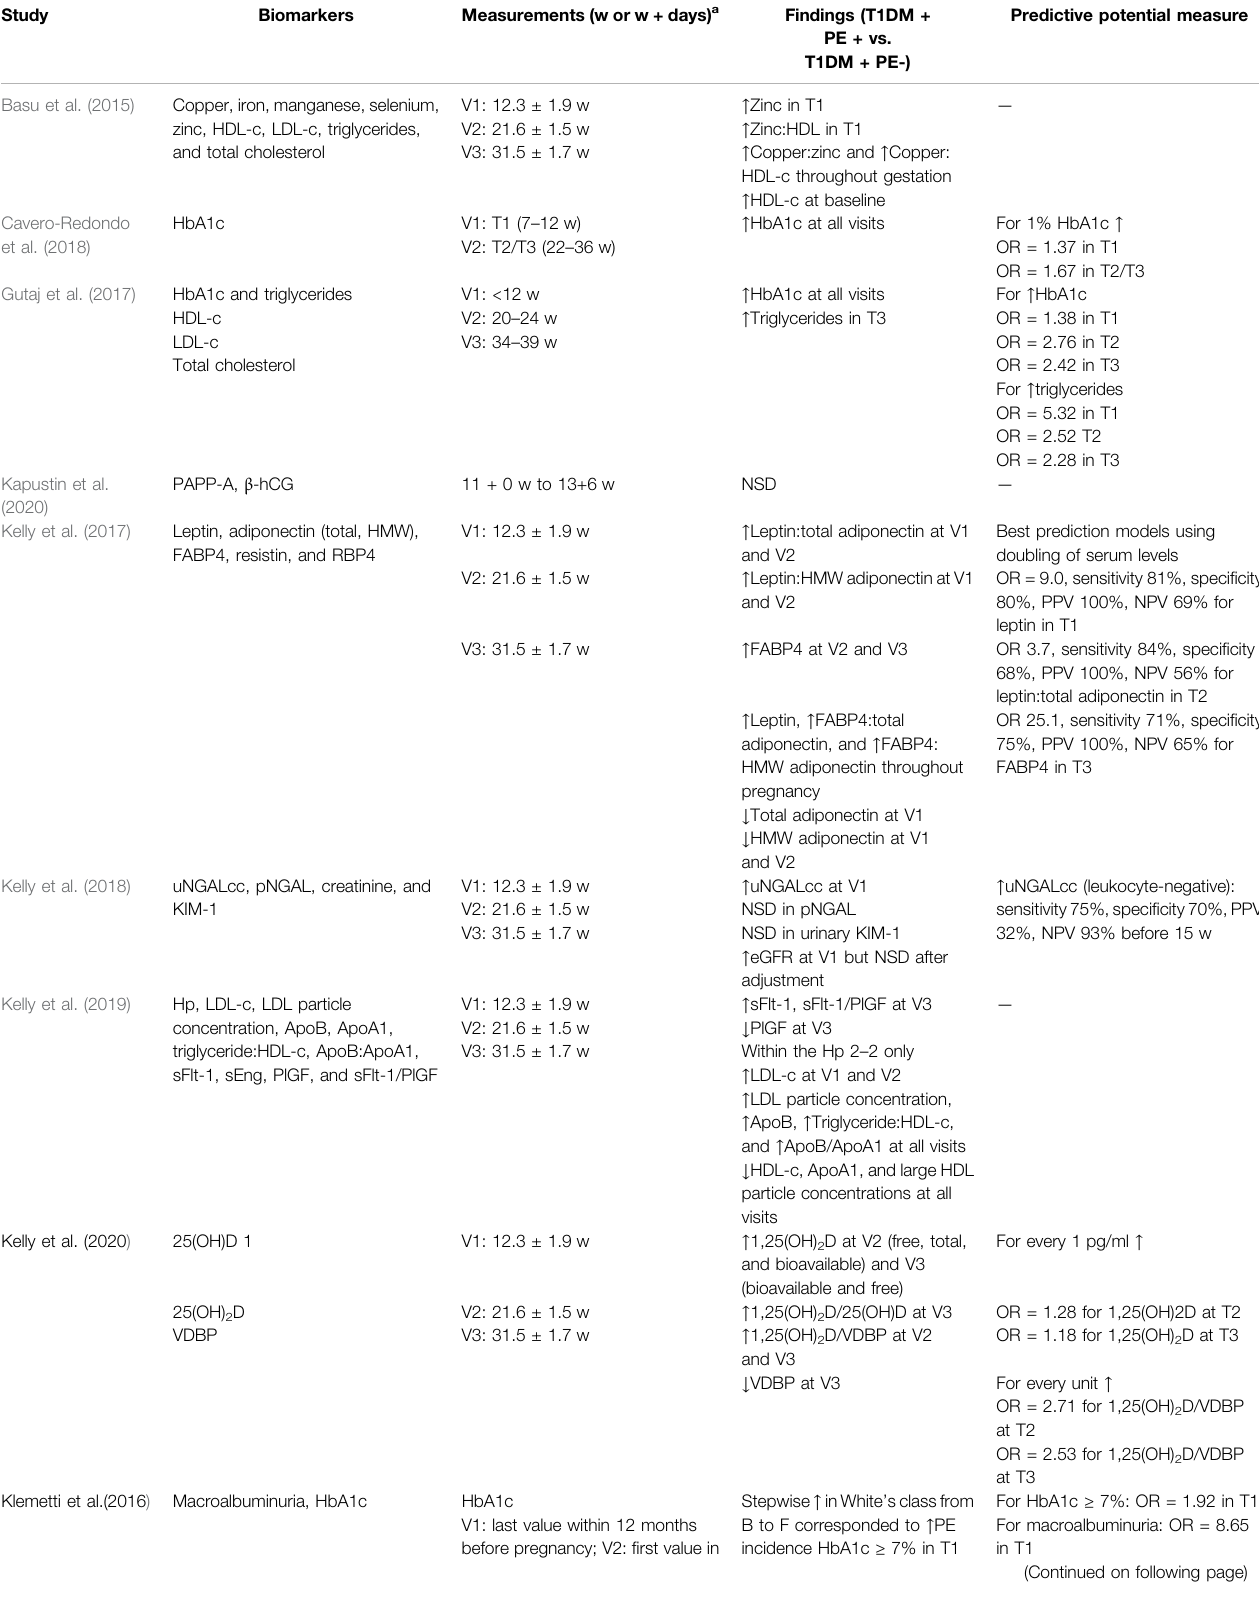
TABLE 3 | Narrative synthesis of biomarkers for pre-eclampsia prediction in women with pregestational T1DM.